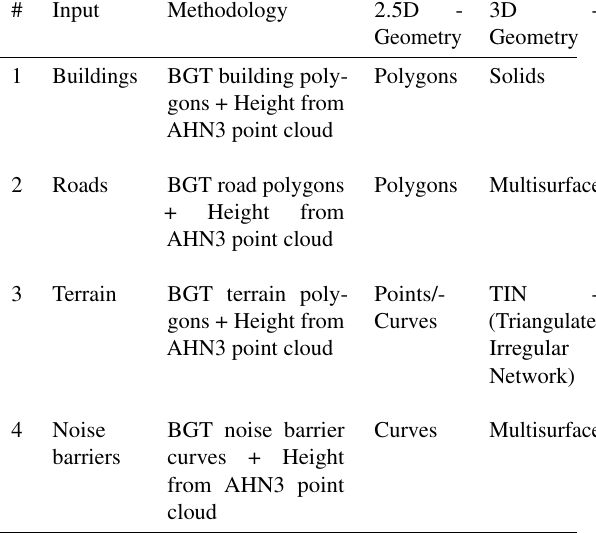
Table 3: Inputs for industrial and road traffic